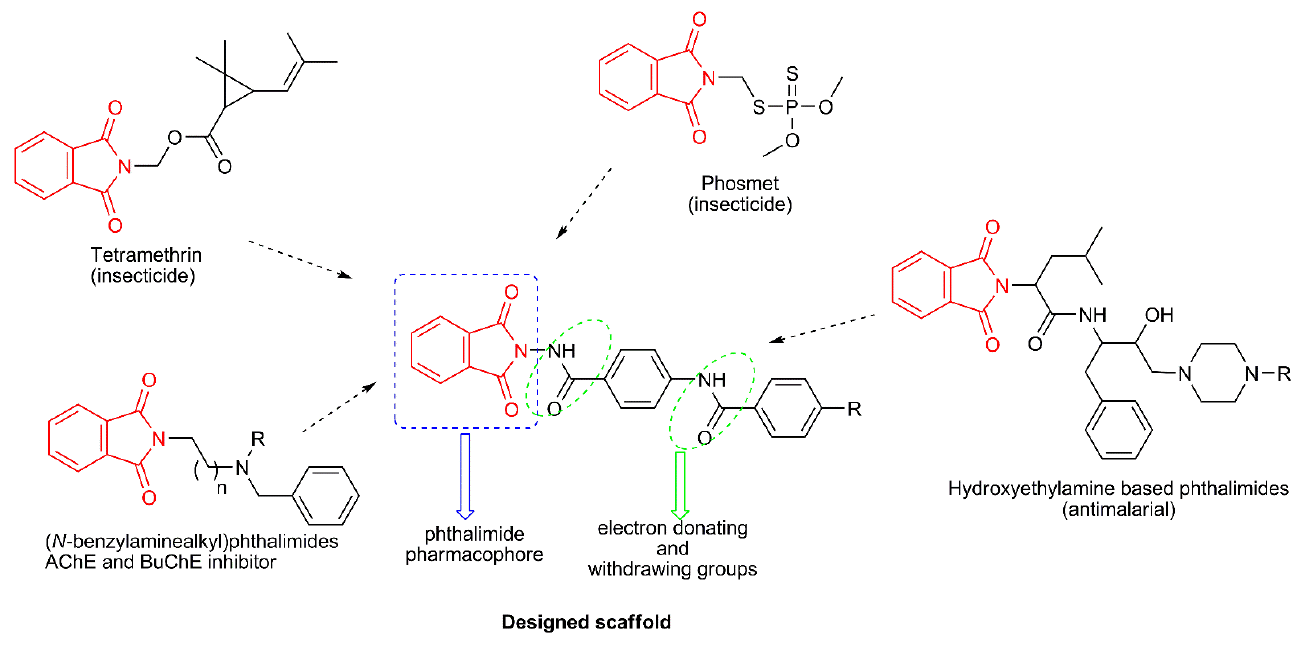
Figure 1. Schematic design strategy of novel molecules based phthalimide.